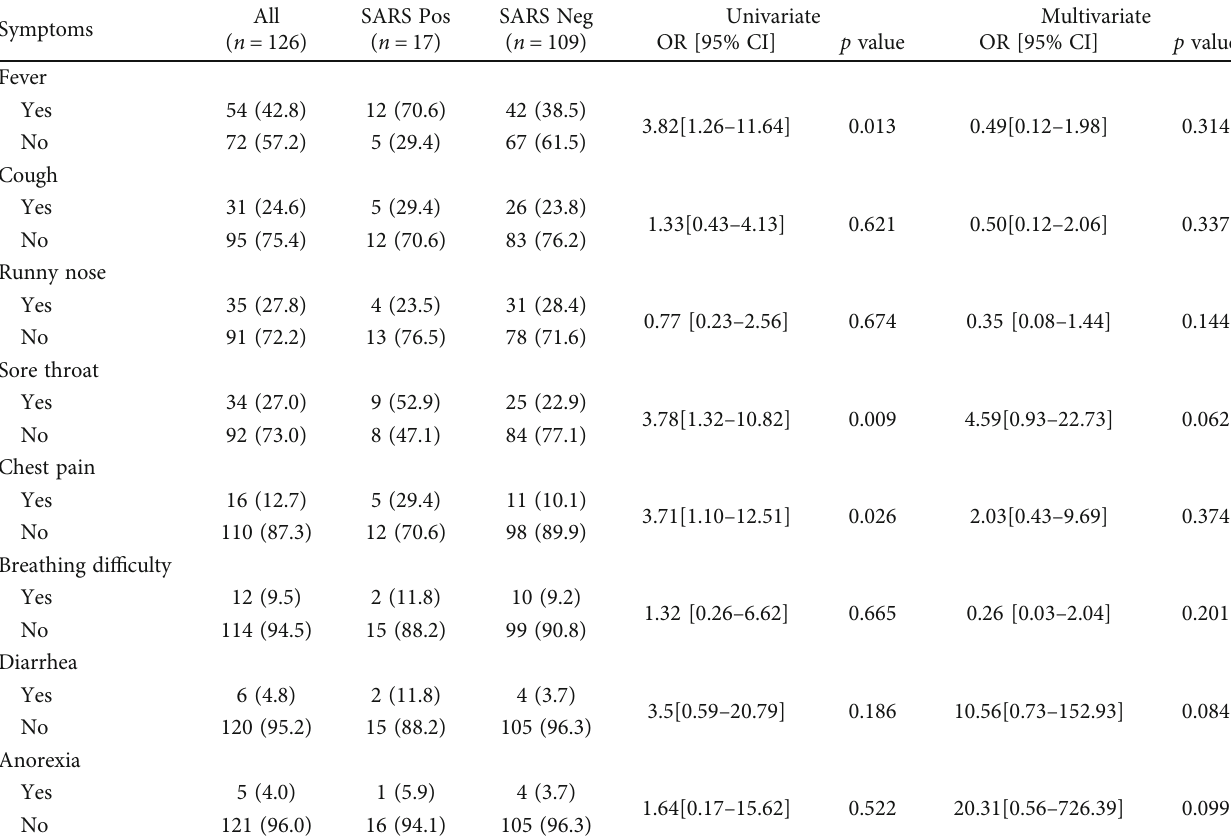
Table 3: Comparison of symptoms among SARS-positive and SARS-negative participants.